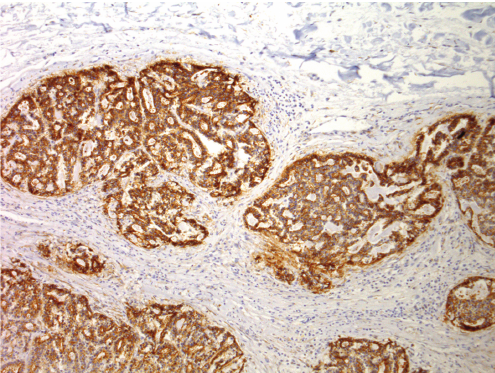
Figure 6: Tubulopapillary carcinoma. Strong aberrant P-cadherin immunoreactivity in the periphery of the tumour (streptavidin- biotin-peroxidase method,